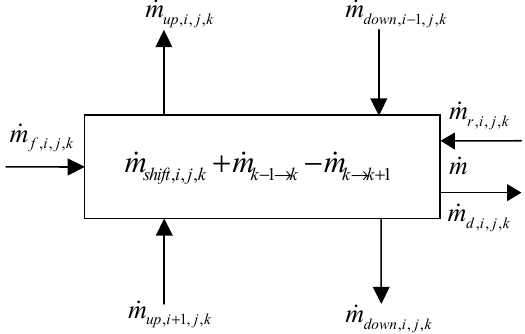
Figure 2. Mass balance of ash particles in size group j and age group k in cell i .